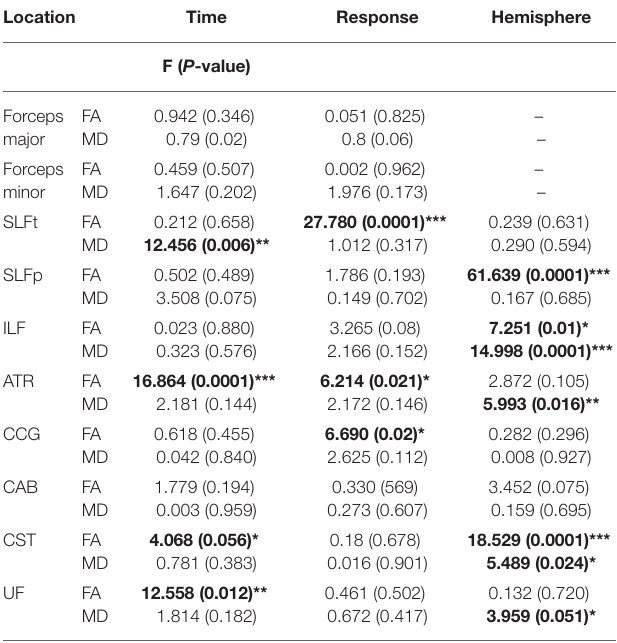
TABLE 4 | The statistical significance of the time, hemisphere and response effects on FA and MD values in tracts of interest for mixed model analyzing regarding age, sex, TMI, and ICV as